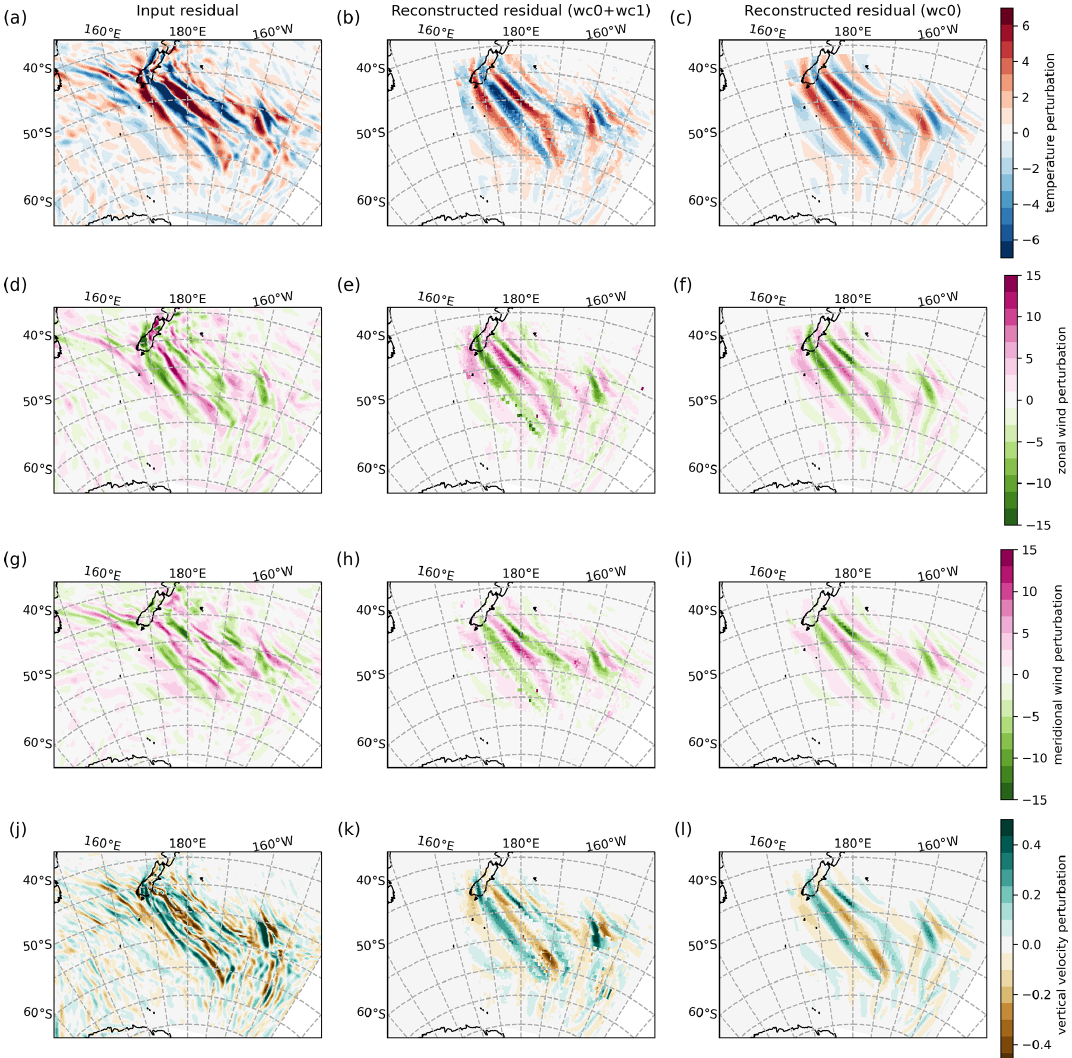
Figure B1. Comparison of input and reconstructed perturbation fields of different atmospheric quantities, namely temperature (a–c) , zonal wind (d–f) , meridional wind (g–i) , and vertical velocity (j–l) at 25km altitude. The input perturbation field are shown in the left column. In the middle column, the reconstructed fields are shown that were generated by considering two S3D fitted wave components in the reconstruction from S3D results. The right column shows a reconstruction from S3D results with only one wave component. Please see the text for more details on the generation of those